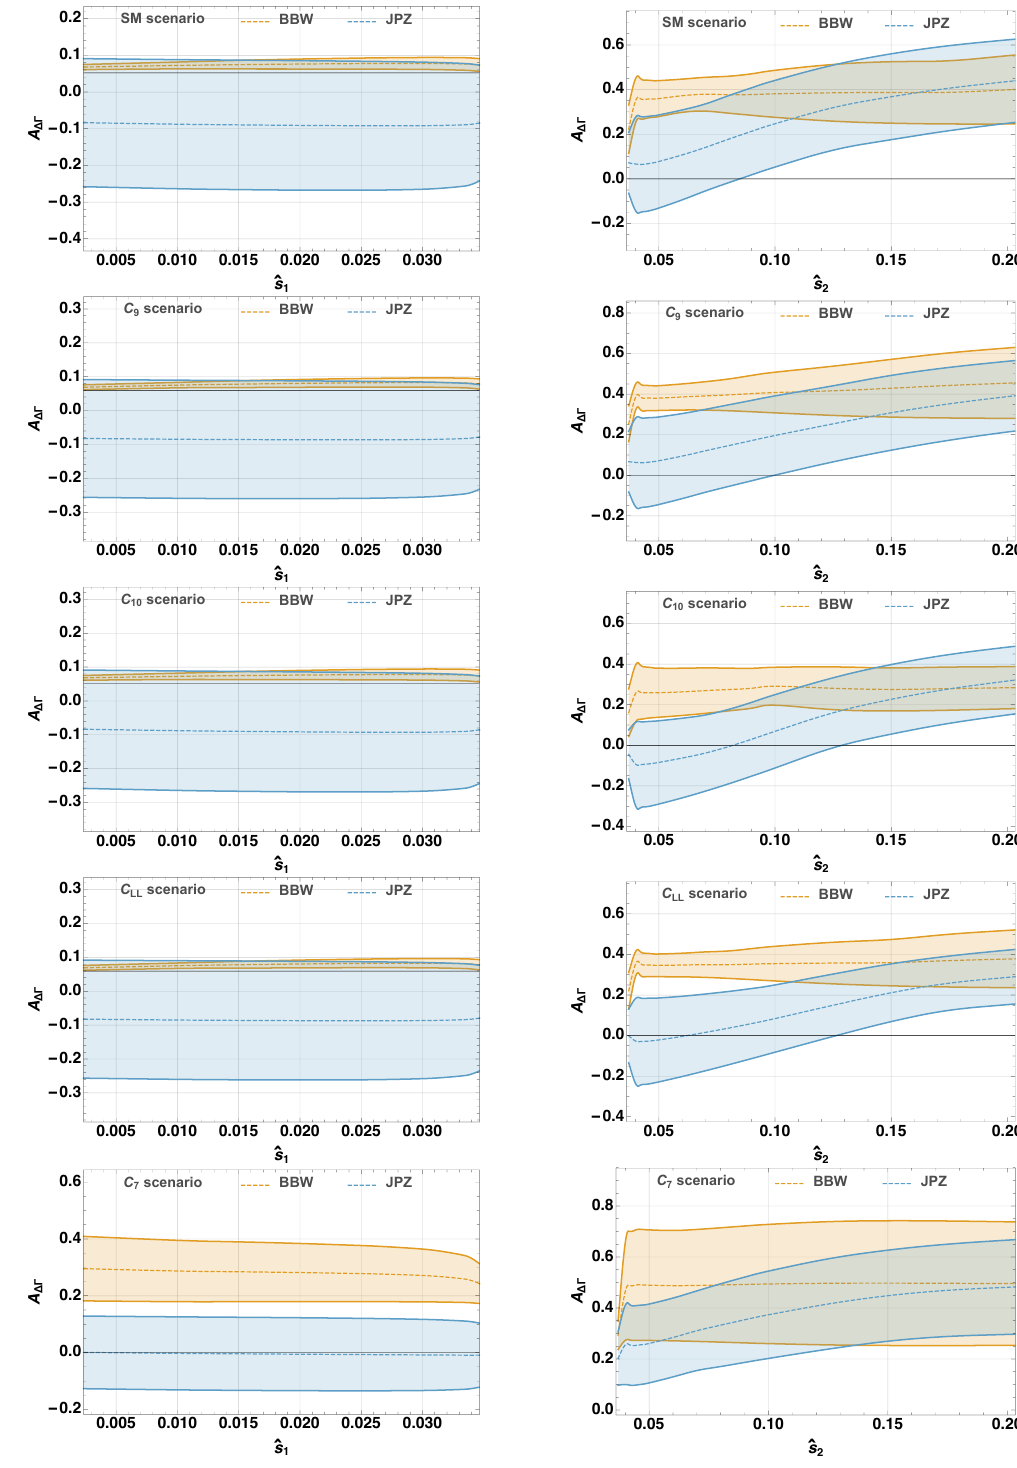
prediction, integrated in the interval [4 m 2 Figure 3 . A µµγ ∆Γ s panels), within the scenarios indicated. We superimpose BBW [22] (yellow) and JPZ [33] (blue) f.f.’s. See text for further